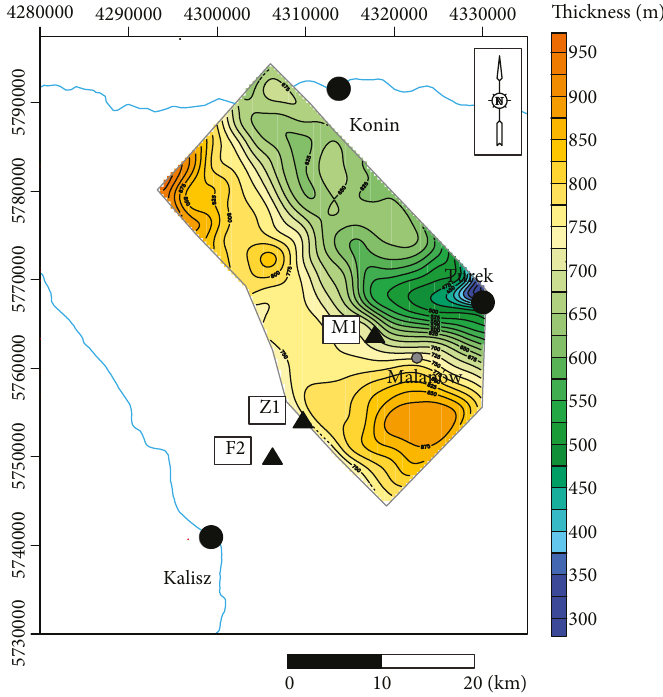
Figure 6: Thickness map of J